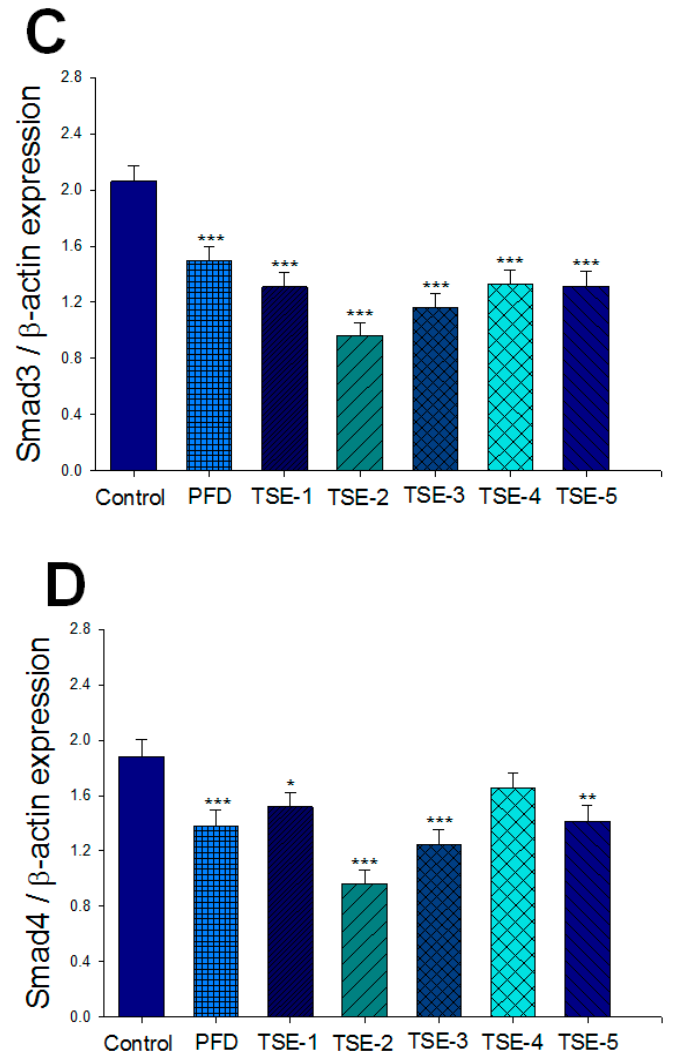
Figure 2. Screening tests of five compounds (including 2,4-dihydro-3H-pyrazol-3-one (DHPO) derivatives) in the expression levels of TGF β 2, SMAD3, or SMAD4 in cells using Western blot. ( A ) Representative image; quantification of ( B ) TGF β 2, ( C ) SMAD3, or ( D ) SMAD4 to β -actin. Protein was separated by 12% SDS-PAGE detected by Western blot. * p < 0.05, ** p < 0.01 or *** p < 0.001 compared to CON cells. Data are the means ± SE (n = 3).